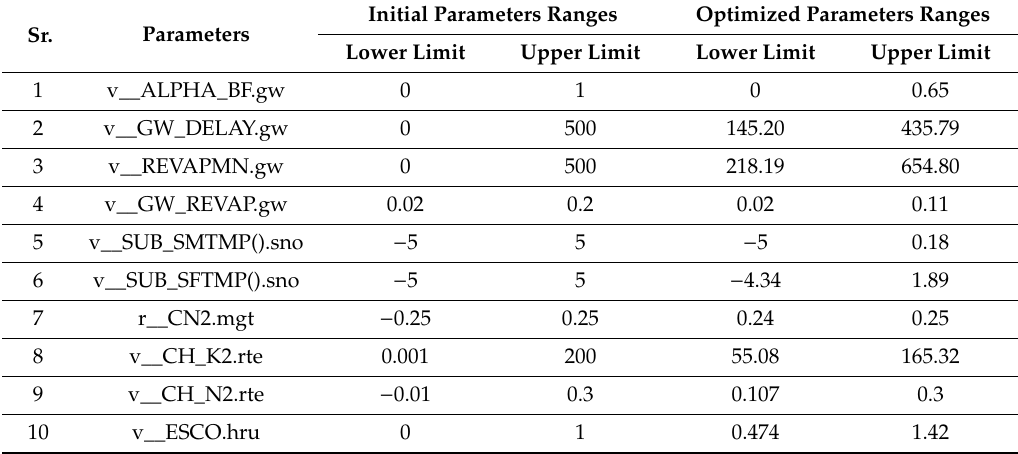
Table 4. Initial and optimized sensitive parameter ranges during calibration of daily IMERG-F.